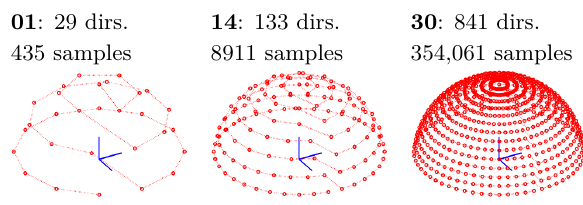
Fig. 7 Three of thirty sampling schemes used for uniform sampling of the hemisphere in conjunction with the barycentric and RBF based methods.